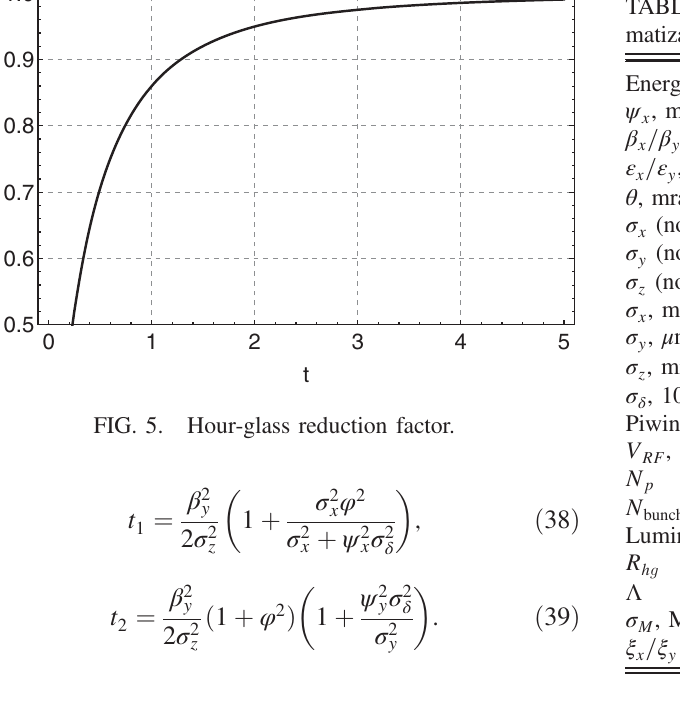
TABLE I. Parameters of FCC-ee with and without monochro- matization for two